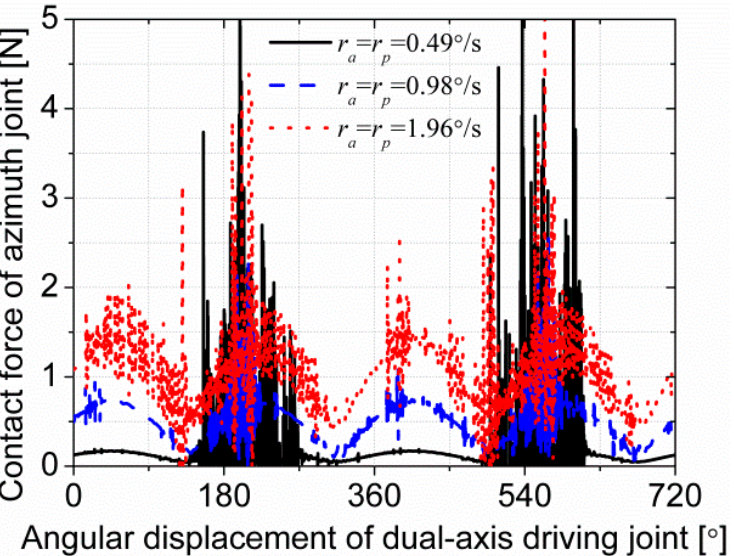
Figure 17. The radial contact force of azimuth joint output side with different rotational speeds.